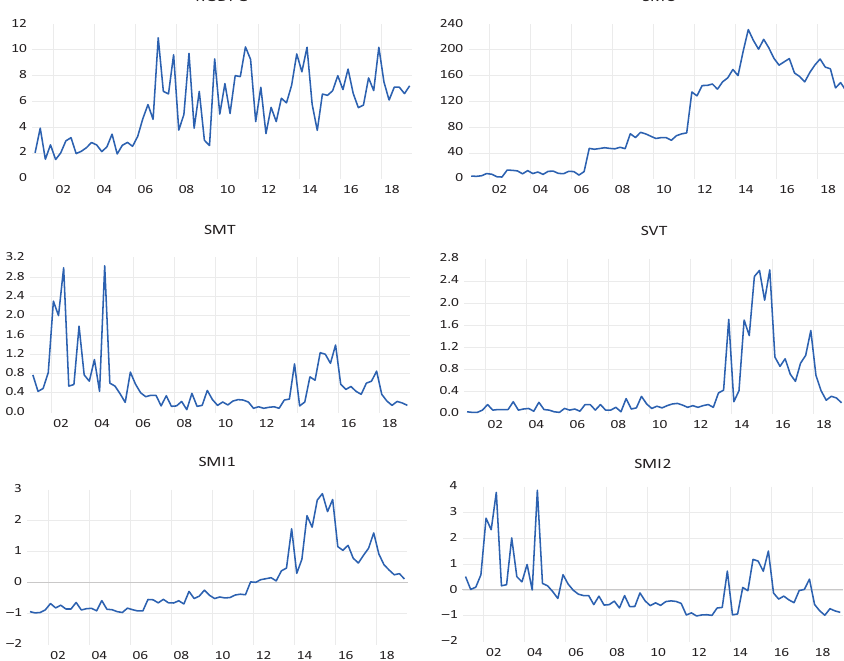
Figure 1. Real GDP growth and stock market development